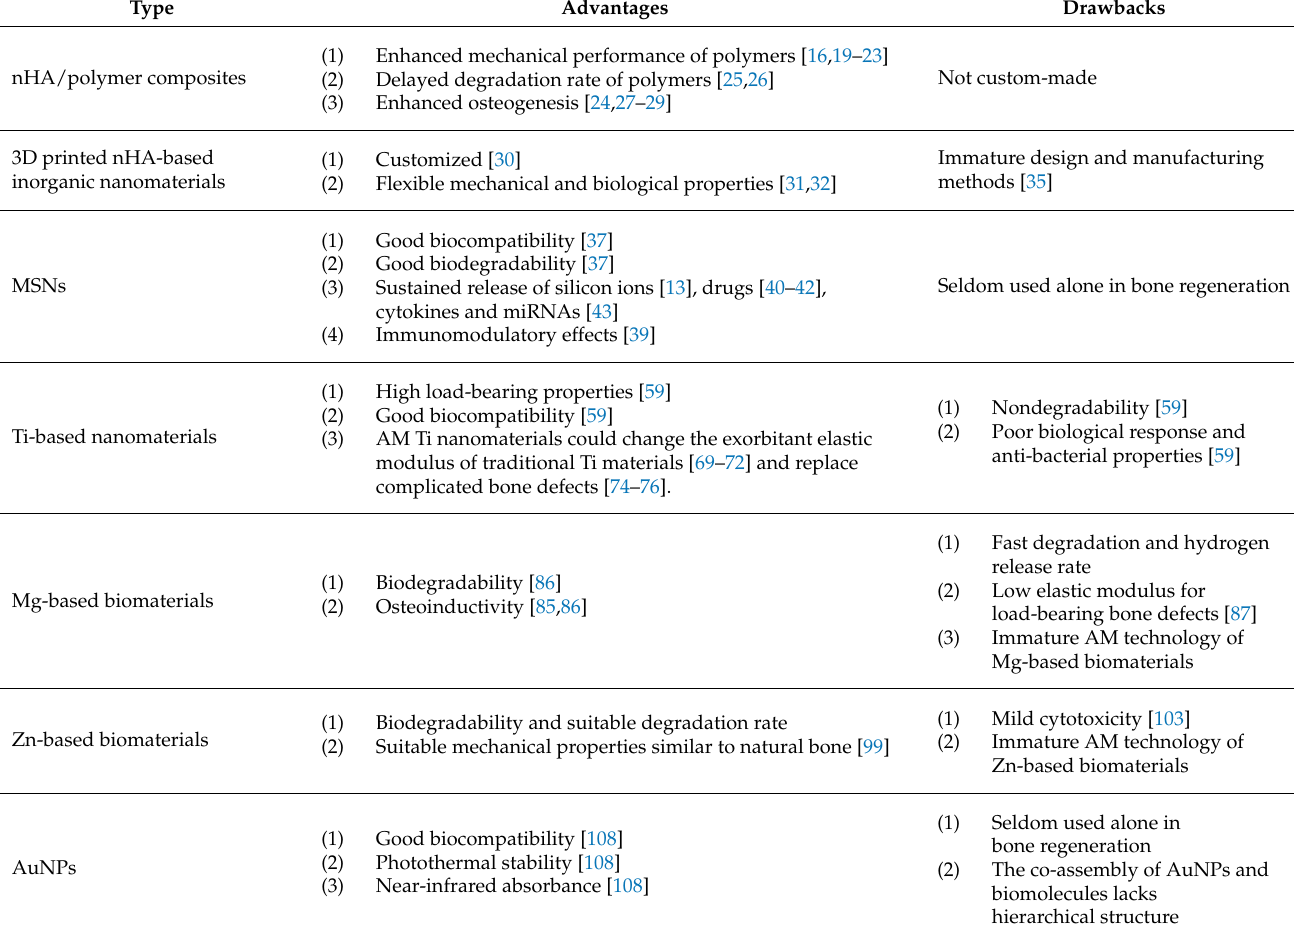
Table 1. The advantages and drawbacks of novel inorganic